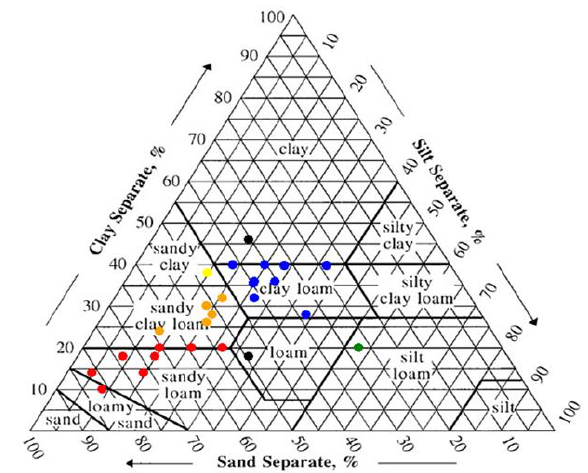
Figure 3. The United States Department of Agriculture (USDA) textural distribution of the soils at the study